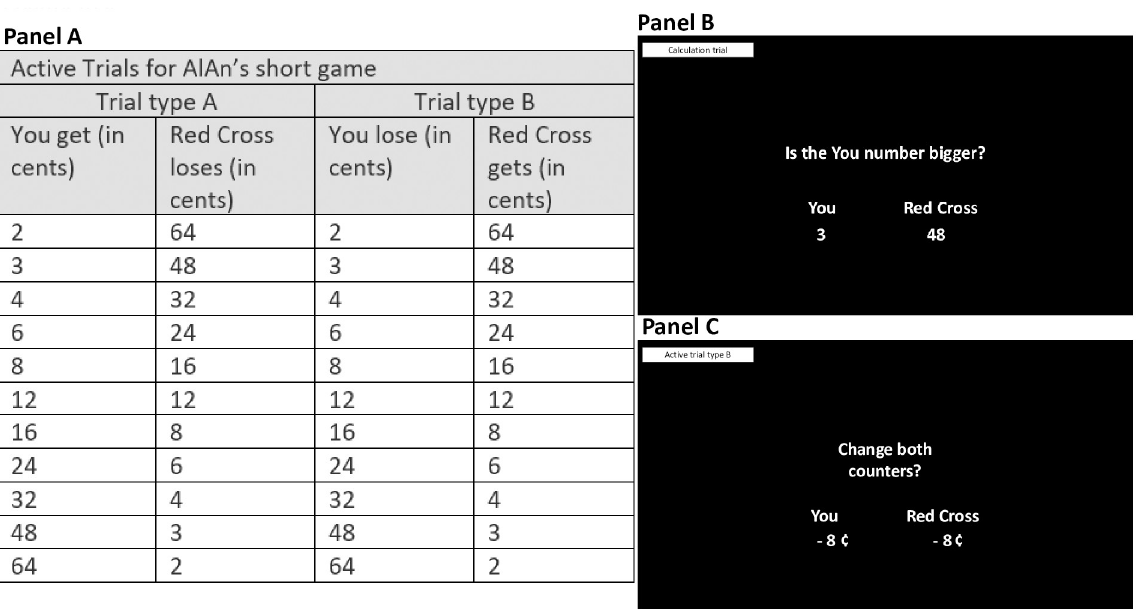
Fig 2. AlAn’s short game version 2 description. Panel A shows the active trial types presented while playing the game. They include trials where “You” gain money but the Red Cross donation is reduced (Active Trial type A). These trial types have been included in previous versions of the game. We also include trials where the participant (“You”) lose money but the Red Cross donation is increased (Active Trial type B, new to version 2) and Calculation Trials ( Panel B ) which ask, “Is the You number bigger?” and present a “You” and “Red Cross” number. Panel C shows an example of an Attention Control